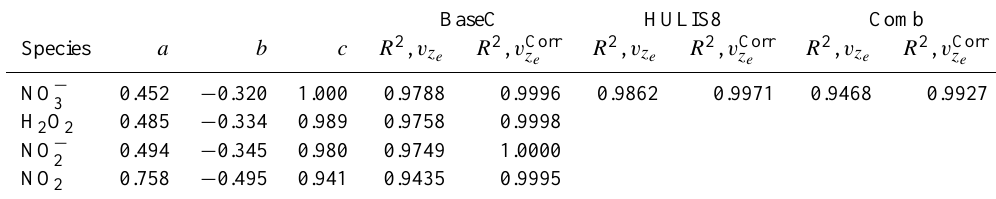
Table 5. Parameterisation correction for “melting and clean” snowpack. Values of the correlation coefficient were calculated for two different snowpacks (Scatt2, HULIS1 and Comb) with and without applying the correction factors. Scatt2 HULIS1 Comb Species a b c R 2 , v z e